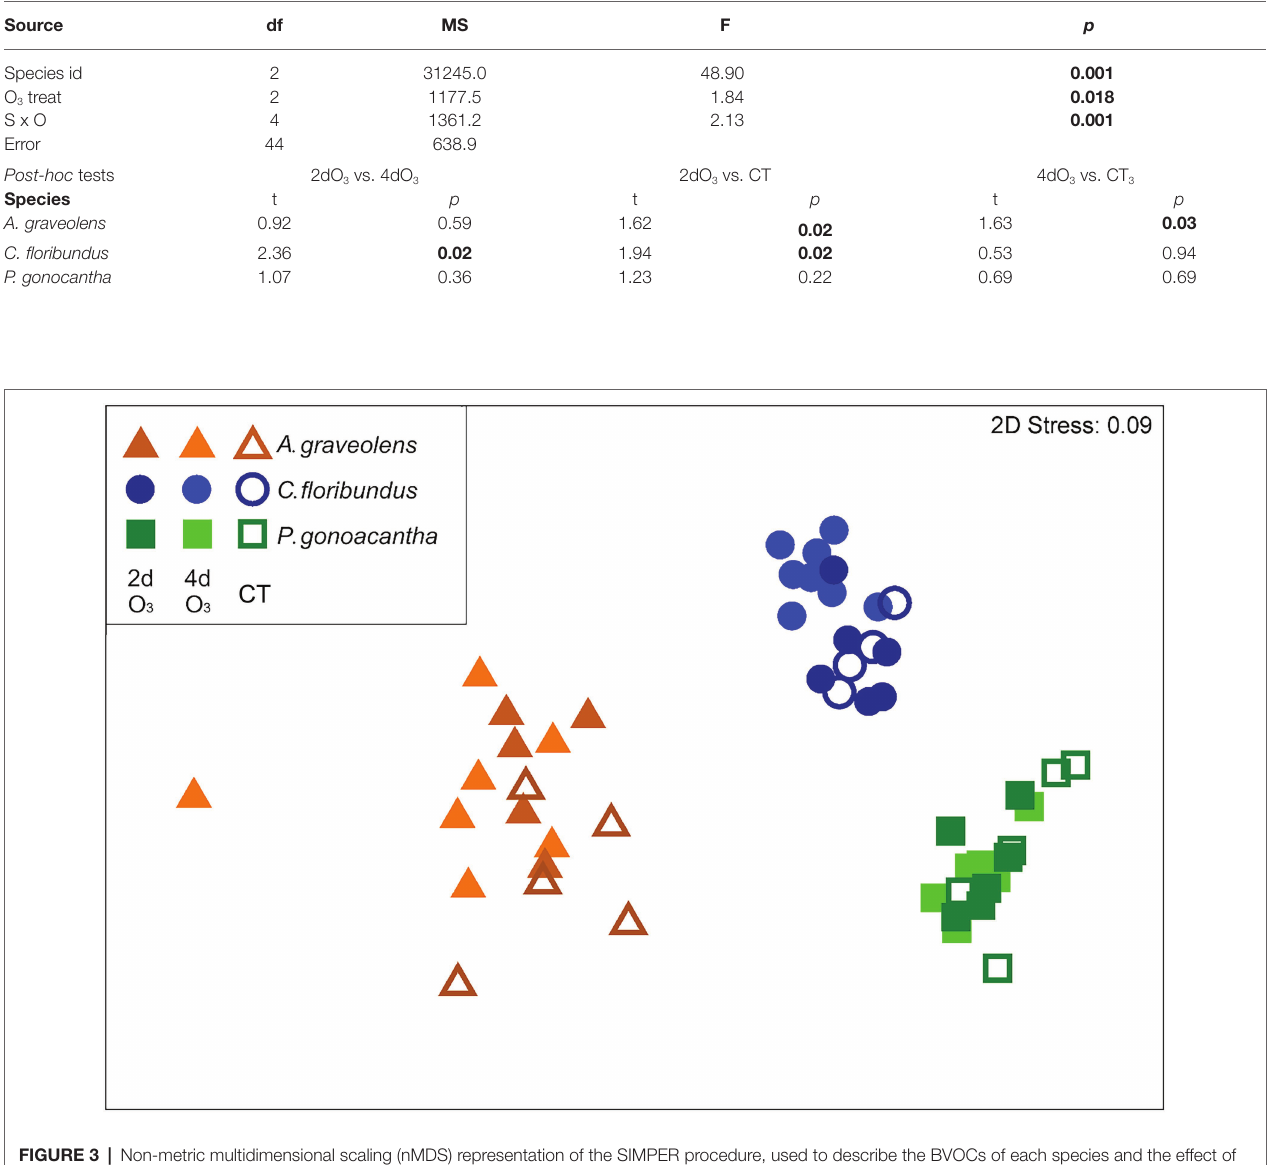
FIGURE 3 | Non-metric multidimensional scaling (nMDS) representation of the SIMPER procedure, used to describe the BVOCs of each species and the effect of O 3 treatment on each